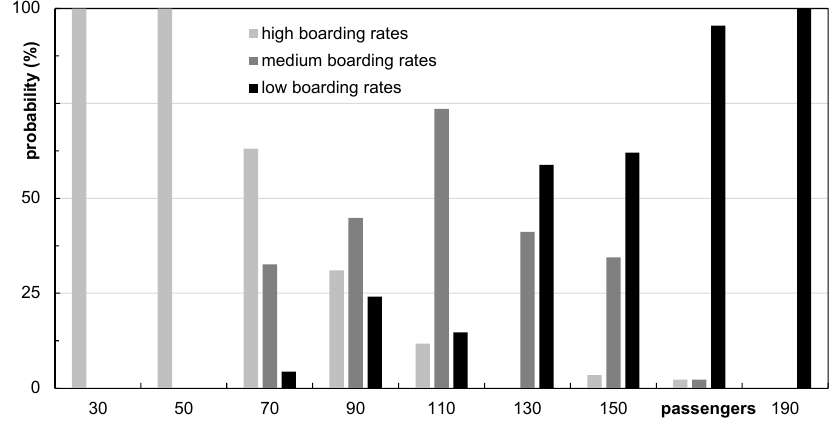
Figure 7. Boarding rate classification (high, medium, and low) for different numbers of passengers.